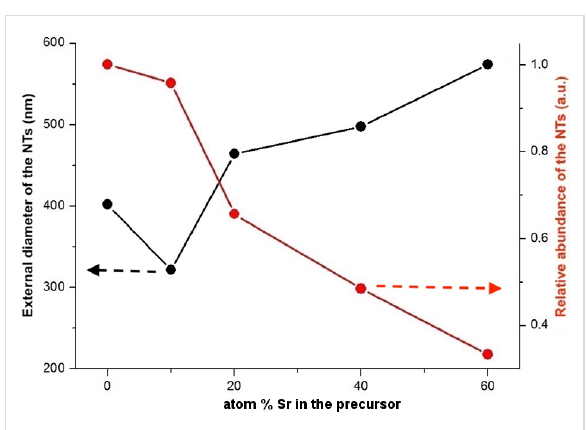
Figure 2: Relative abundance of the nanotubes (red curve) in the product and their average outer diameter (black curve) determined from the SEM